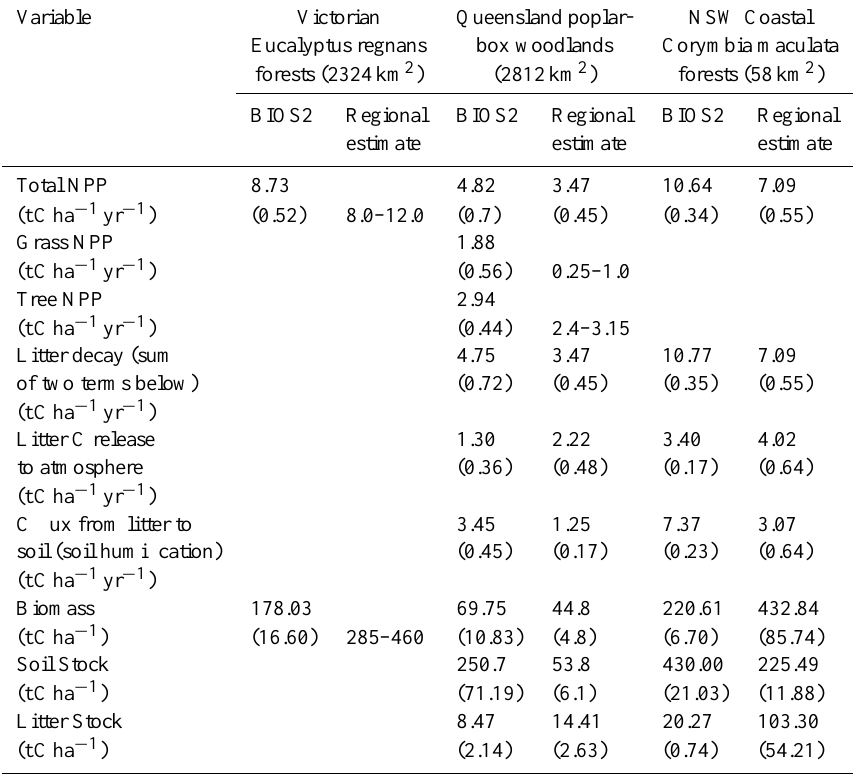
Table 3. Comparison of regionally-based carbon budget components for three forest ecosystems with BIOS2 predictions.